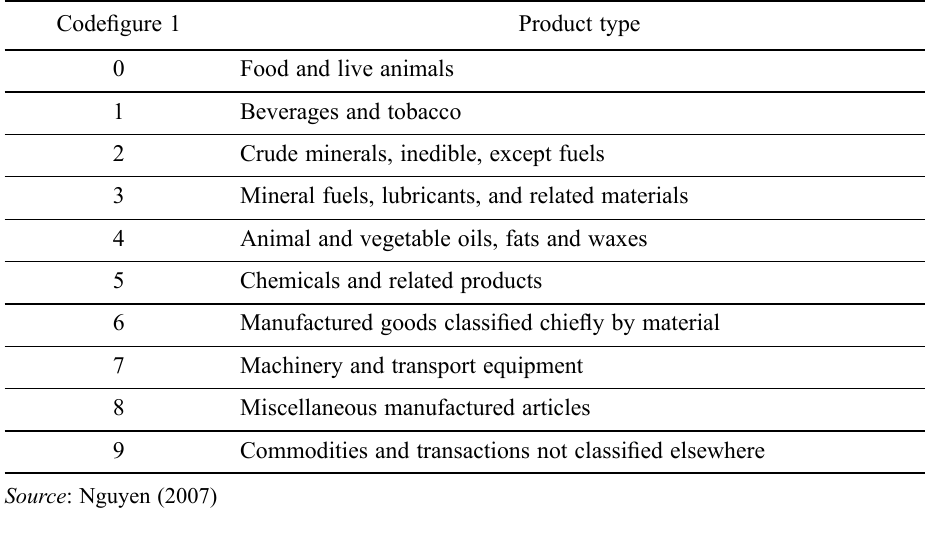
Table 1. United Nation’s Standard International Trade Classification (SITC) Revision 2